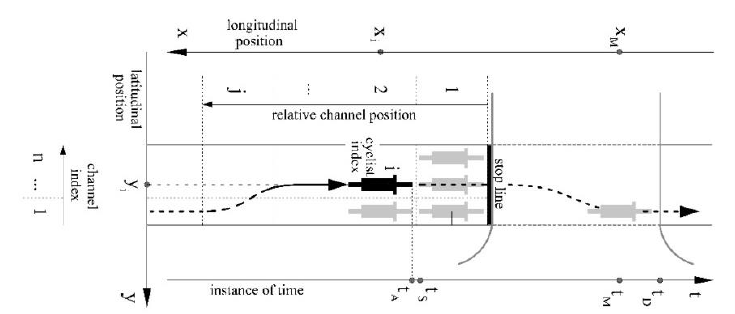
Figure 3. Sample queue (Q(5,3))